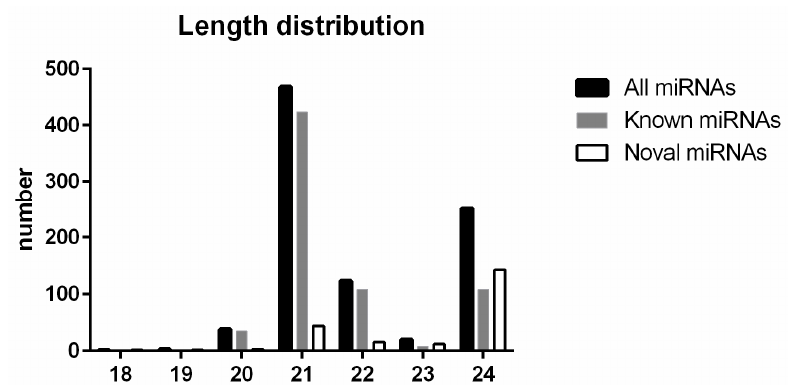
Figure 2. Length distribution of known, novel and total miRNAs in all 9 libraries. X -axis represents the base numbers of miRNAs; Y -axis represents the accumulation numbers with the same length.